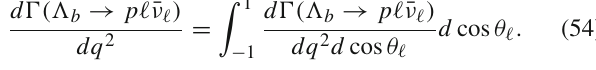
plotted in Fig. 7 for (cid:3) = e , μ, τ , which lead to the inte- grated branching ratios B ((cid:2) b → p (cid:3) ¯ ν (cid:3) ) = ( 16 ± 11 ) × 10 − 4 with (cid:3) = e , μ and B ((cid:2) b → p τ ¯ ν τ ) = ( 11 ± 7 ) × 10 −